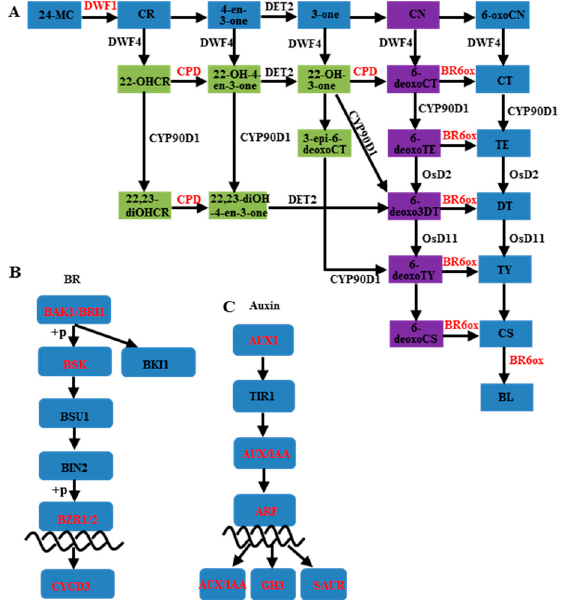
Figure 4. Schematic diagrams of ( A ) the BR biosynthesis pathway, ( B ) BR signal transduction pathway, and ( C ) auxin signaling transduction pathway. Genes marked in red indicate those differentially expressed between the two lines.